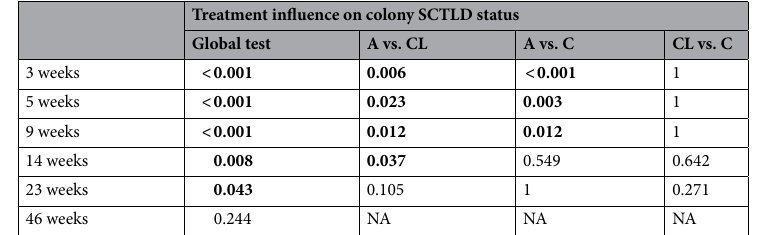
Table 1. Fisher’s exact tests and pairwise Fisher’s exact test comparing SCTLD status between treatment groups at each time point. Specifically, the p values that are significant for each pairwise comparison represent a difference detected between quiesced vs. not quiesced (dead or diseased) at that time point. A = Base 2B plus amoxicillin treatment (n = 11), CL = chlorinated epoxy treatment (n = 11), and C = untreated SCTLD- affected controls (n = 10). Significant p-values are bolded, NAs represent lack of pairwise comparisons due to insignificant global